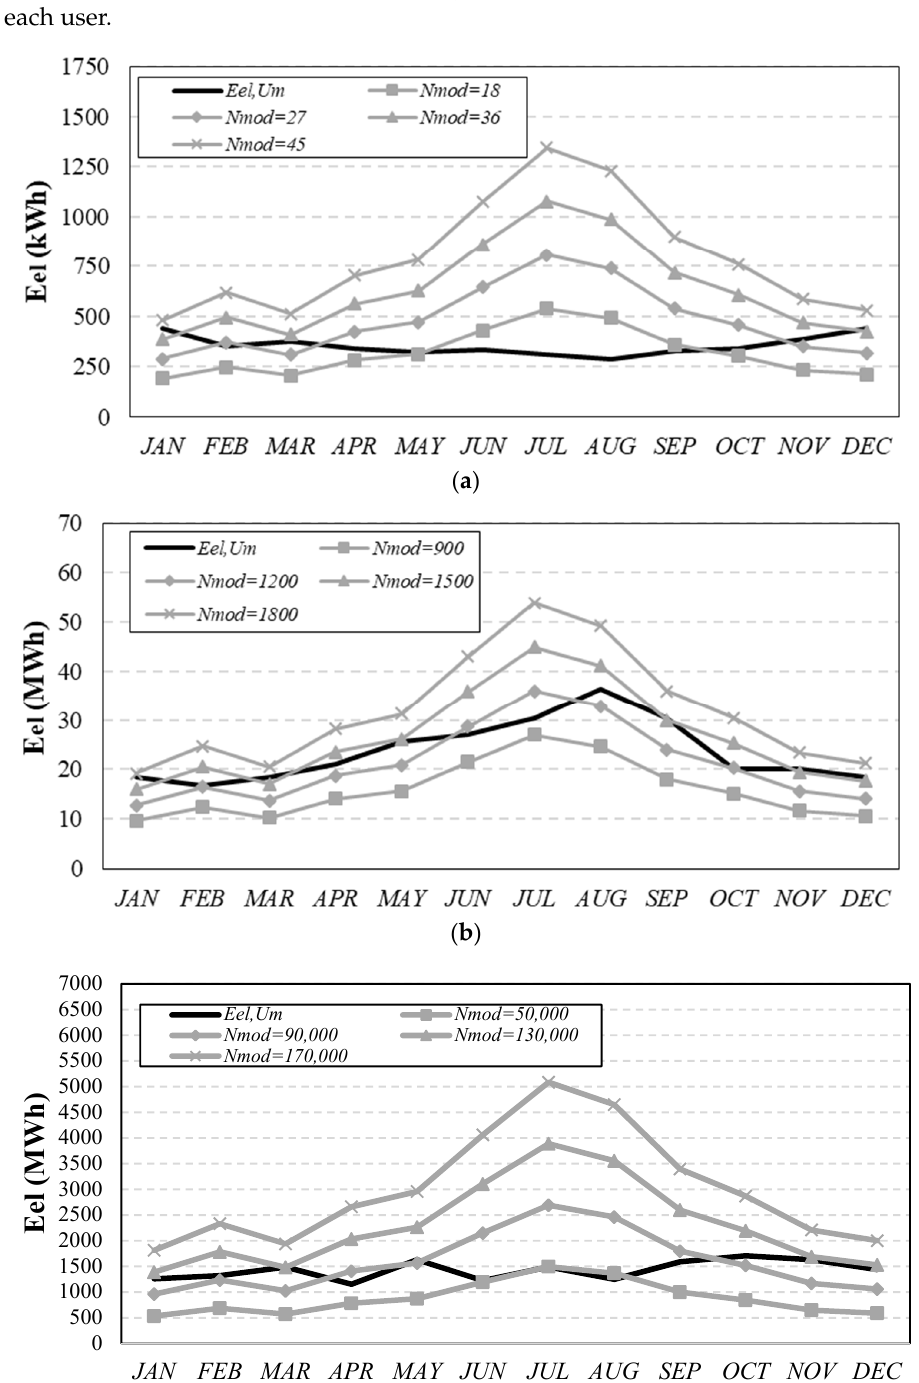
Figure 4. Difference between the CPV/T system electrical outputs on a monthly basis by varying its number of modules and the electrical loads of the three users: ( a ) house; ( b ) hotel; and ( c ) industry. As shown, the domestic user presents a monthly electrical load which is not extremely variable during the year. Hence, in the summer period, the CPV/T system